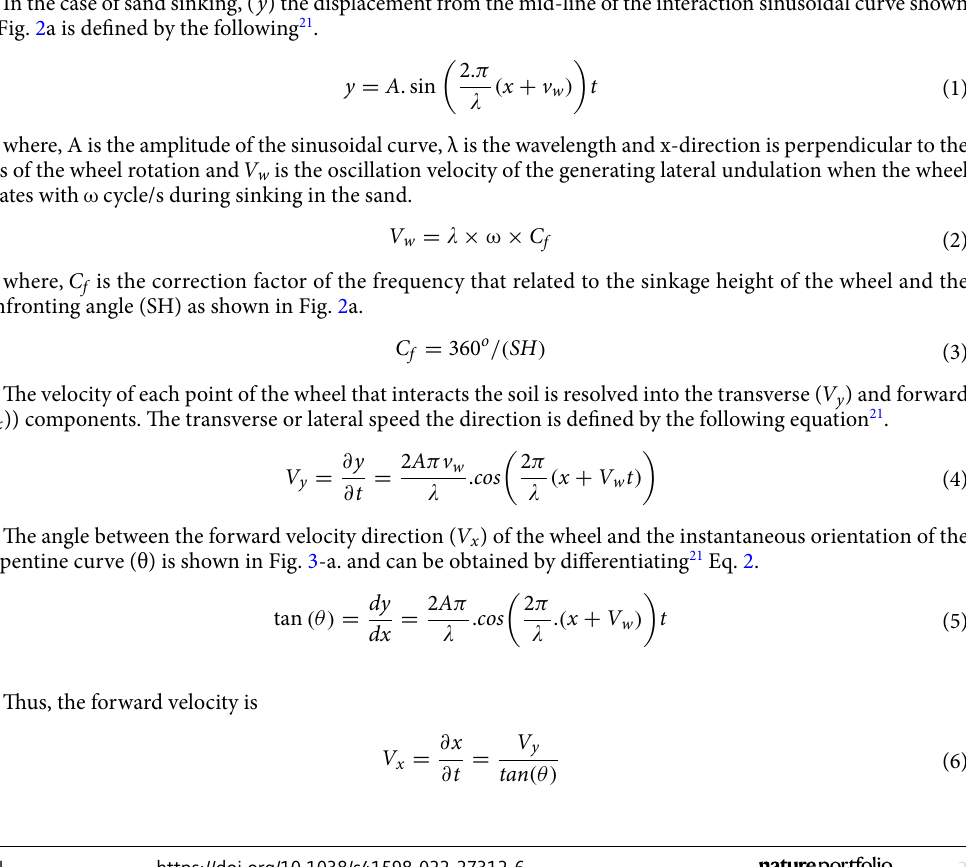
size of particles.